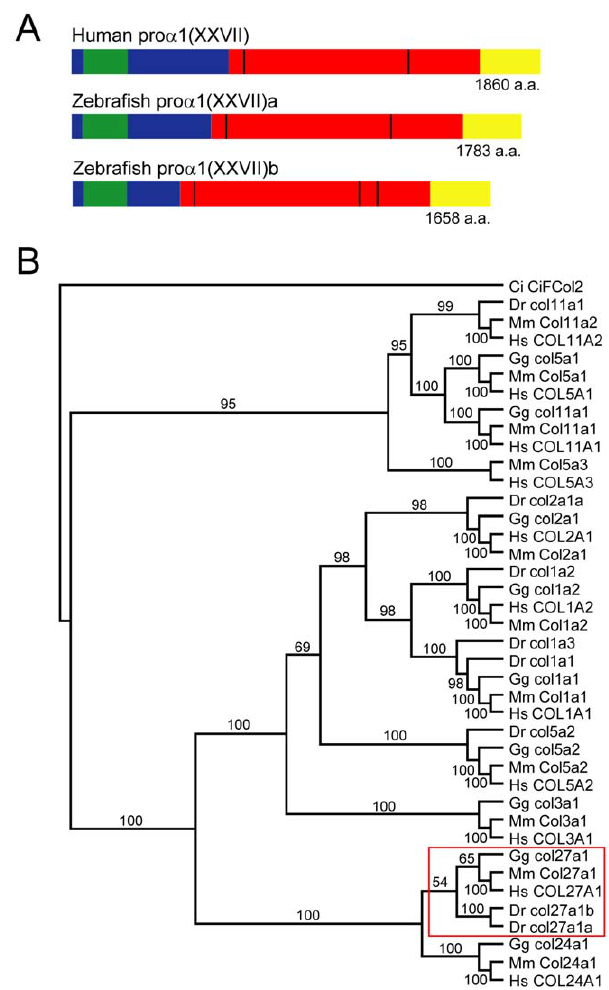
Figure 1. Identification of two type XXVII collagen genes in zebrafish. (A) Protein schematic showing domains of human and zebrafish type XXVII collagen. Blue: N-propeptide, Green: thrombos- pondin domain, Red: triple helical domain, Yellow: C-propeptide, Black: interruptions of the triple helix. Total protein length is listed in amino acids. (B) Fibrillar collagen phylogeny based on amino acid sequences from the conserved C-propeptide. Bayesian tree with posterior probabilities is shown. The two predicted type XXVII collagen proteins in zebrafish cluster with those of chicken, mouse and human (red box). Ci, Ciona intestinalis ; Dr, Danio rerio ; Gg, Gallus gallus ; Mm, Mus musculus ; Hs, Homo sapiens .